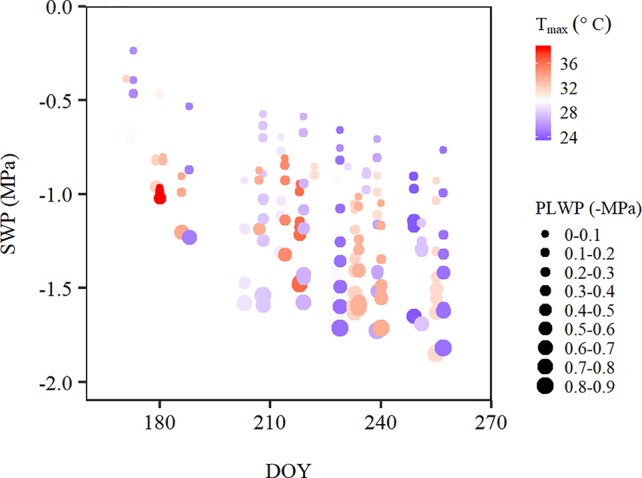
Stem water potential over the course of the 2015 and 2018 growing season along a temperature gradient [Tmax, from 23.8°C (blue) to 38.9°C (red)], where the size of the points corresponds to predawn leaf water potential (PLWP) categories in steps of 0.1 MPa. Data was averaged for each plot within each PLWP category. DOY, day of the year.